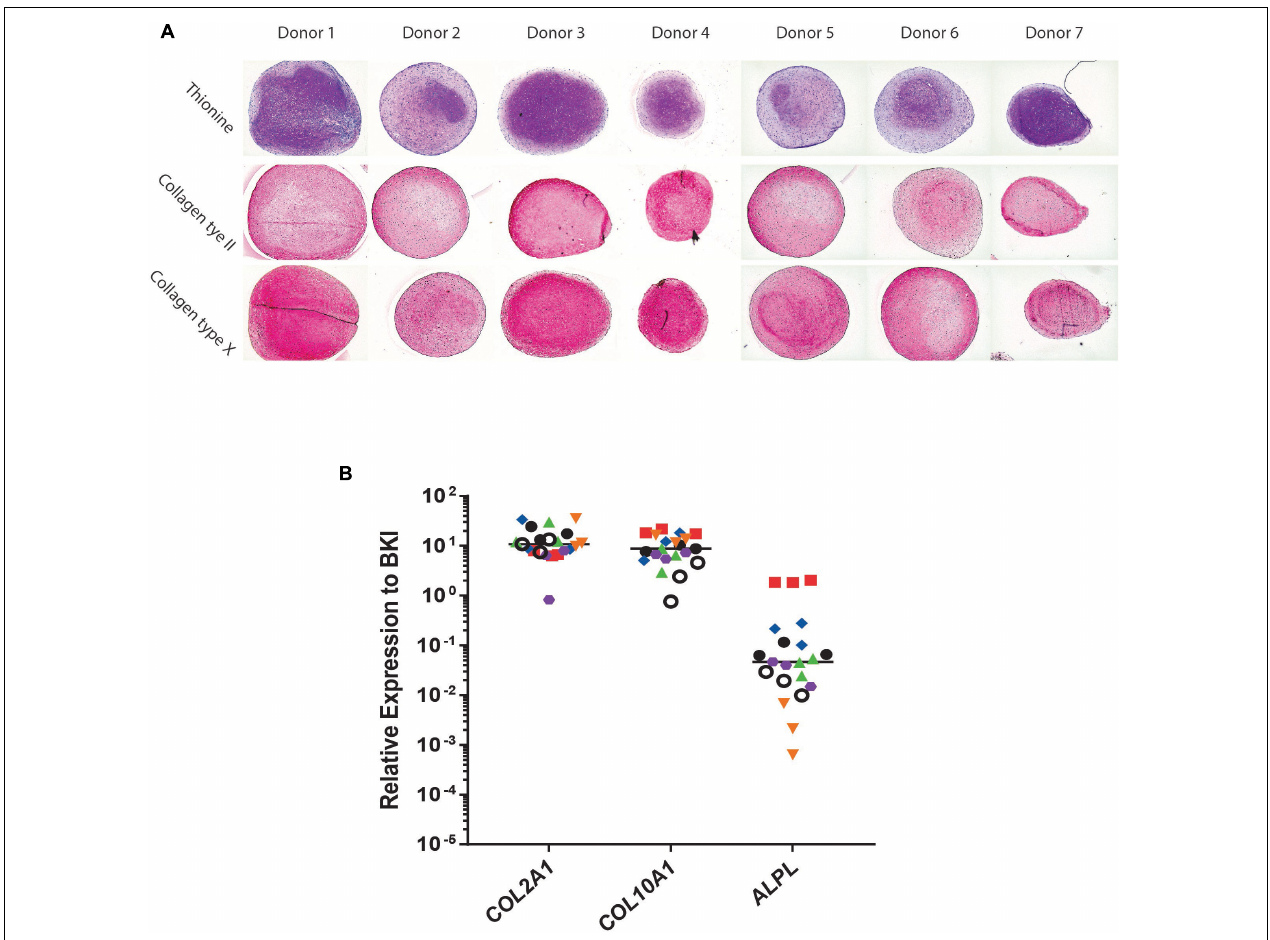
FIGURE 1 | Chondrogenic differentiation of bone marrow derived mesenchymal stem cells (BMSC). (A) Histological and Immunohistological staining of day 21 chondrogenically differentiated BMSC-pellets of the donors for Collagen type II, Thionine and Collagen type X. (B) qPCR Gene-expression analysis of chondrocyte and hypertrophy marker genes in day 21 chondrogenically differentiated BMSCs. Raw average Ct value for COL2A1 = 20.54; COL10A1 = 20.99; ALPL = 28.19.